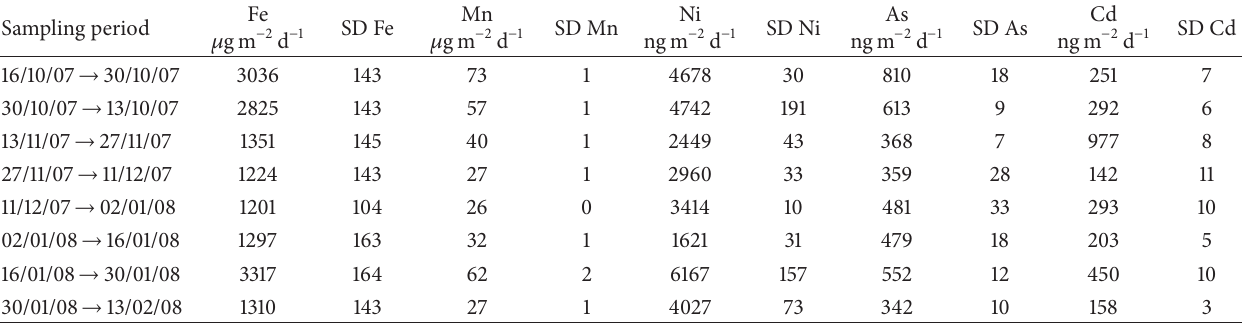
Table 4: Bulk deposition flux and the measurement uncertainty (SD) of Fe and Mn 𝜇 g m − 2 d −1 and of Ni, As, and Cd ngm − 2 d − 1 with standard deviation for the urban background